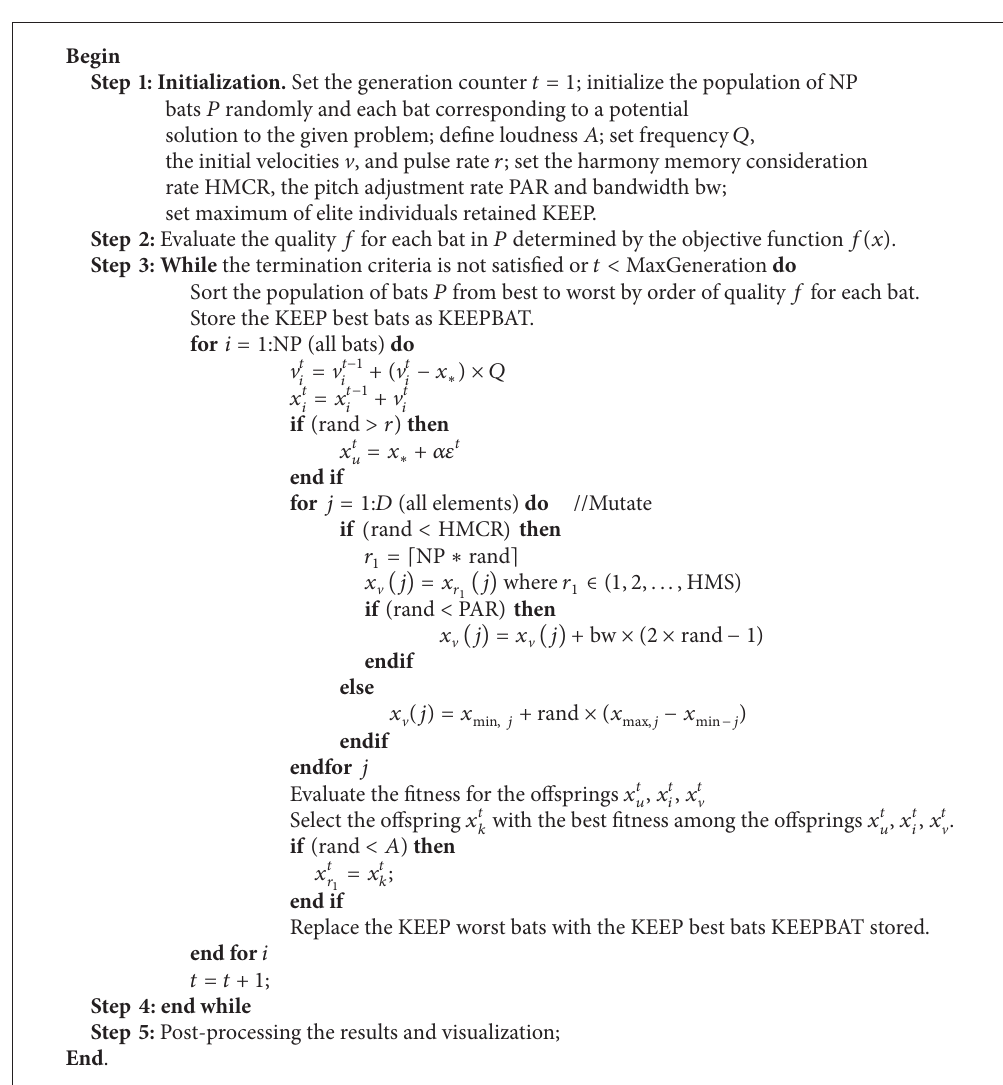
Algorithm 3: The hybrid meta-heuristic algorithm of